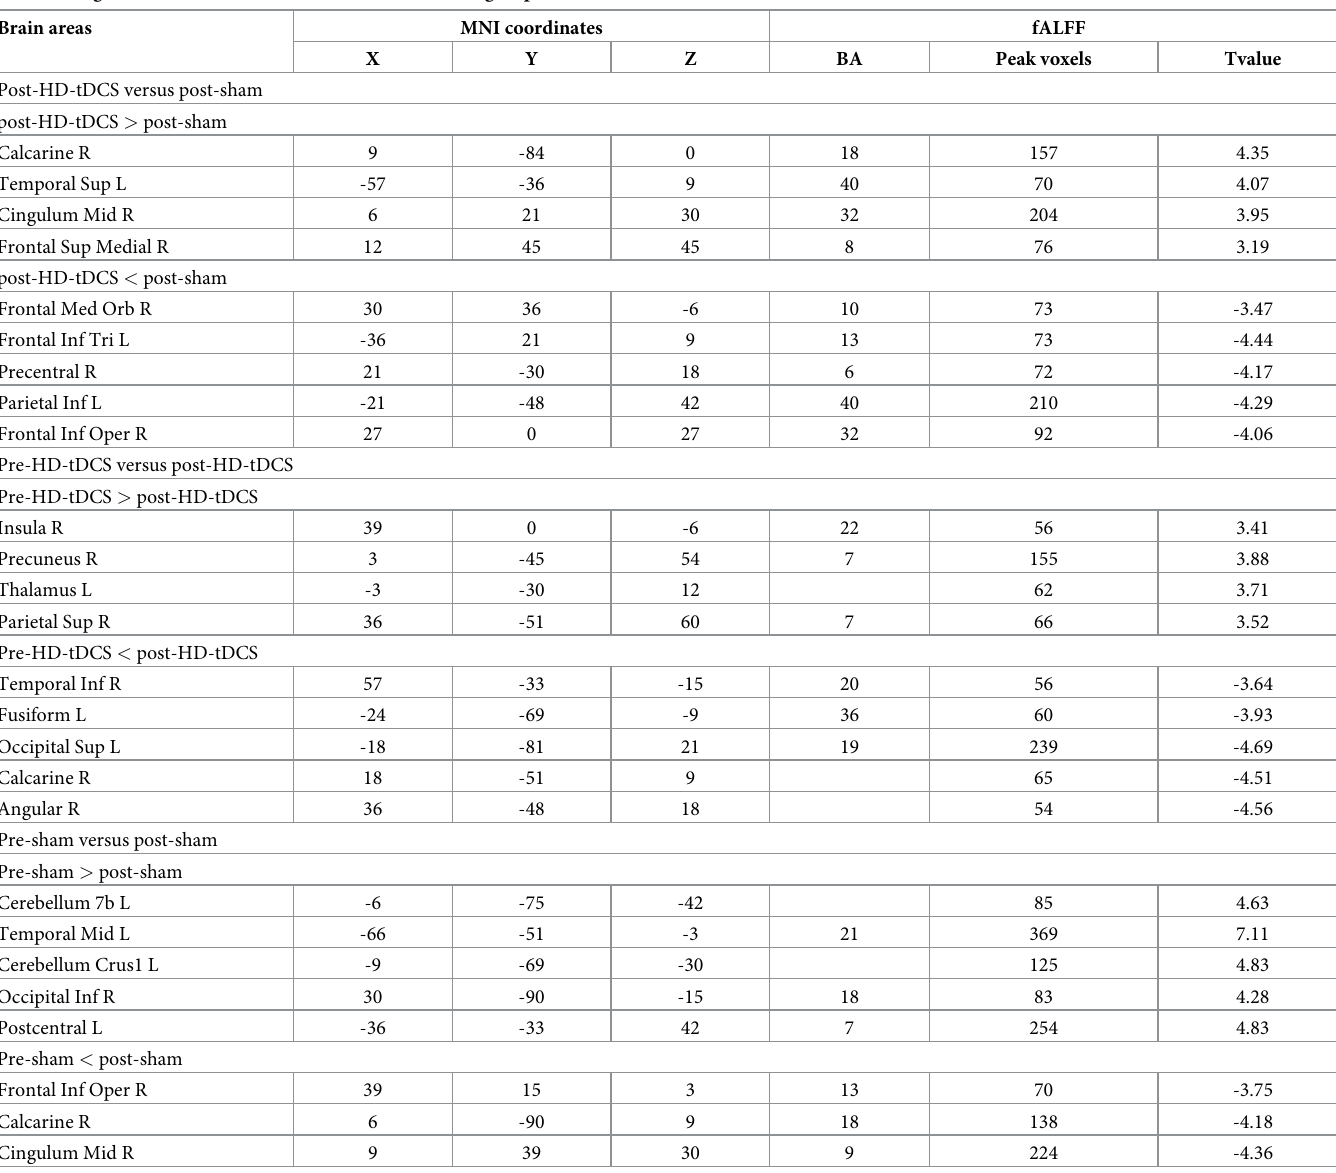
Table 3. Regions with fALFF differences between each two